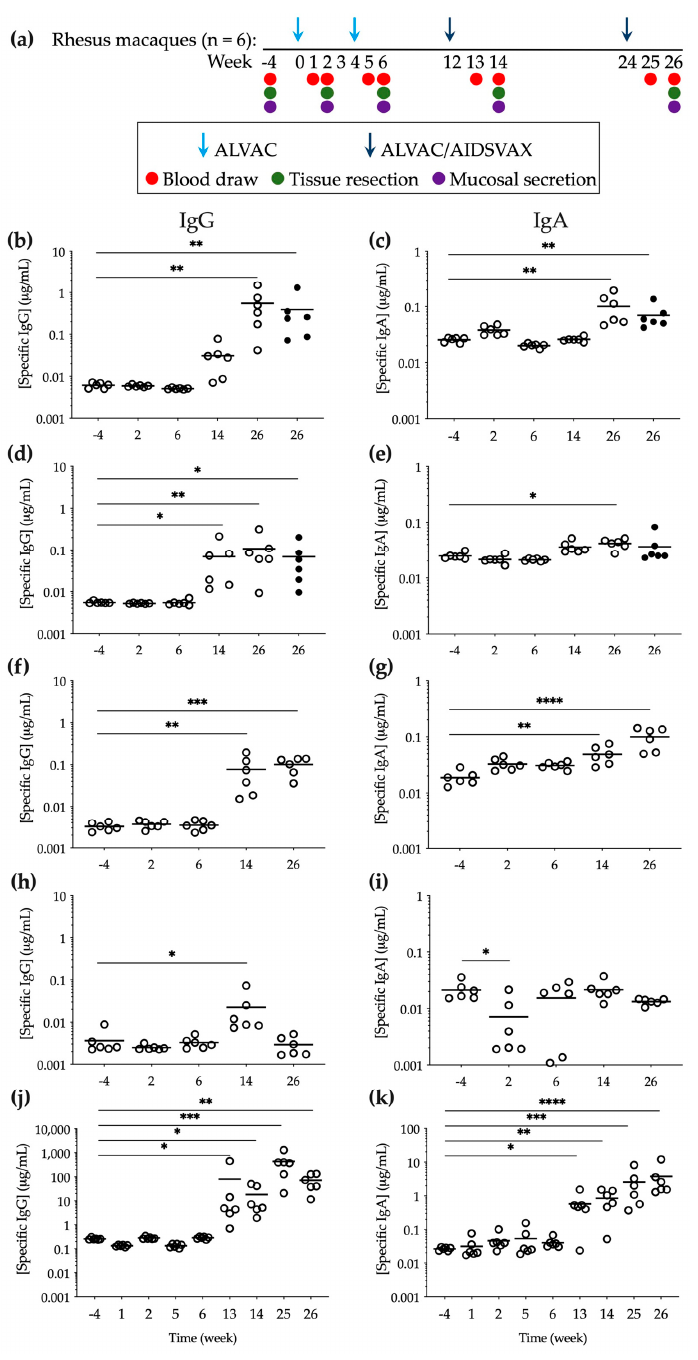
Figure 1. Specific anti-gp120 HIV-1 CM244 IgG and IgA levels elicited during vaccination with AL- VAC/AIDSVAX. ( a ) Immunization and sampling schedule. ( b – e ) Explant culture supernatants were harvested during the 15 days of culture of tissues obtained 2 weeks after each vaccination (( b , c ) cervical (open symbols) and vaginal (closed symbols); ( d , e ) rectal (open symbols) and sigmoidal (closed symbols)). The data shown are the sum of the Ab concentrations measured in triplicate at harvest days 3, 7, 11, and 15 during the culture period for tissue explants from each macaque. ( f , g ) Vaginal and ( h , i ) rectal secretions were extracted from Weck-Cel sponges collected from each animal 2 weeks after each vaccination, and Ab concentrations were measured in triplicate. ( j , k ) Serum was obtained for each animal from blood collected 1 and 2 weeks after each vaccination and Ab concentrations were quantified in triplicate. Means are shown with lines. Statistical significance: * p ≤ 0.05, ** p ≤ 0.01, *** p ≤ 0.001, **** p ≤